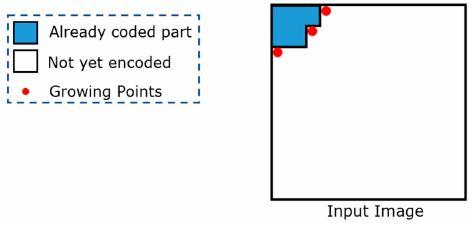
Figure 3. Examples of growing points.